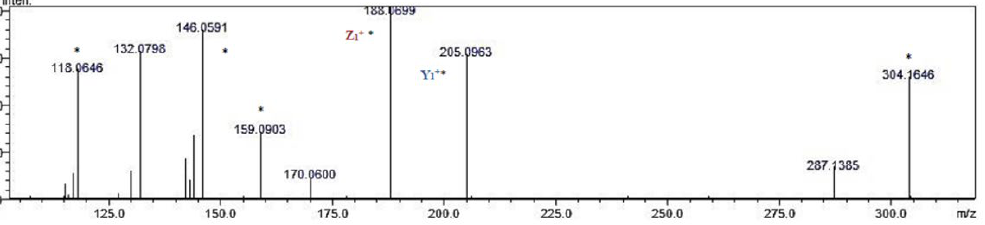
Figure 4. MS/MS spectrum of multifunctional peptide VW identified in oat kernels proteins digest (* mass of fragmentation ions also appearing on METLIN spectra). Fragment ion nomenclature according to Roepstorff and Fohlman (1984) [60].